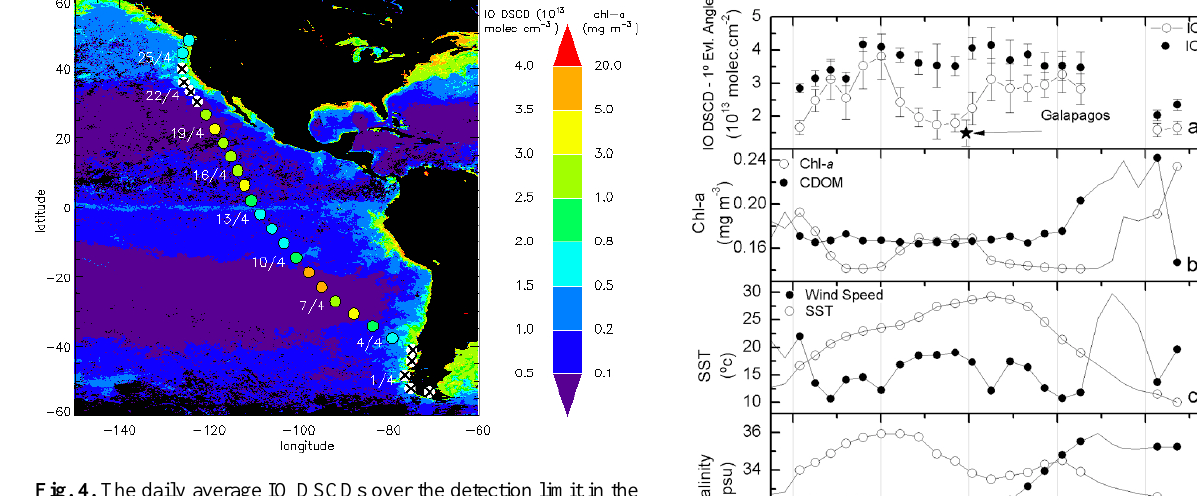
Fig. 4. The daily average IO DSCDs over the detection limit in the 1 ◦ viewing elevation angle after the data was filtered for clouds along with satellite estimated Chl a distribution for April 2010 (NASA-GSFC, 2011). The empty white circles with crosses show days where measurements were not possible.